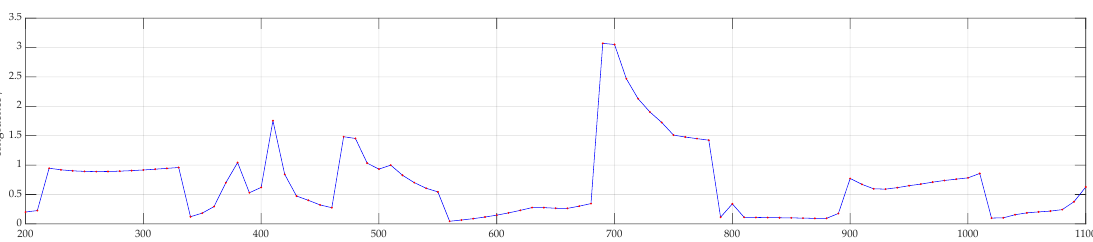
Figure 8. Overall congruence of 681 nm measurement to simulation database.